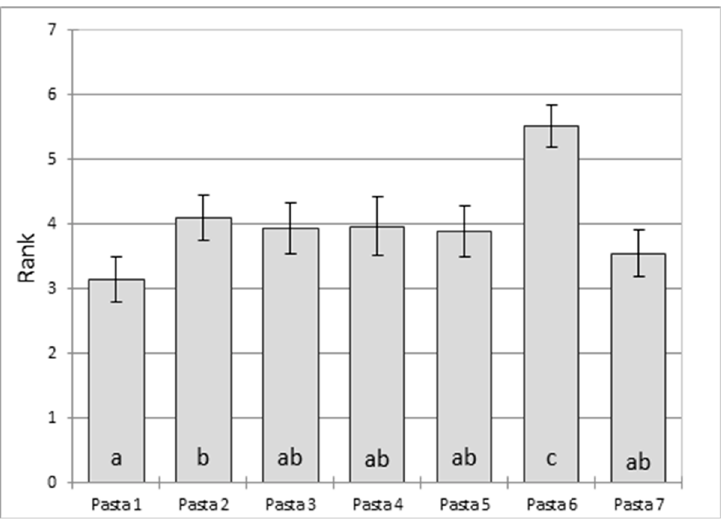
Figure 5. Results of ranking tests based on hedonic characteristics. a–c Mean values labeled with the same letter are not significantly different ( p > 0.05).